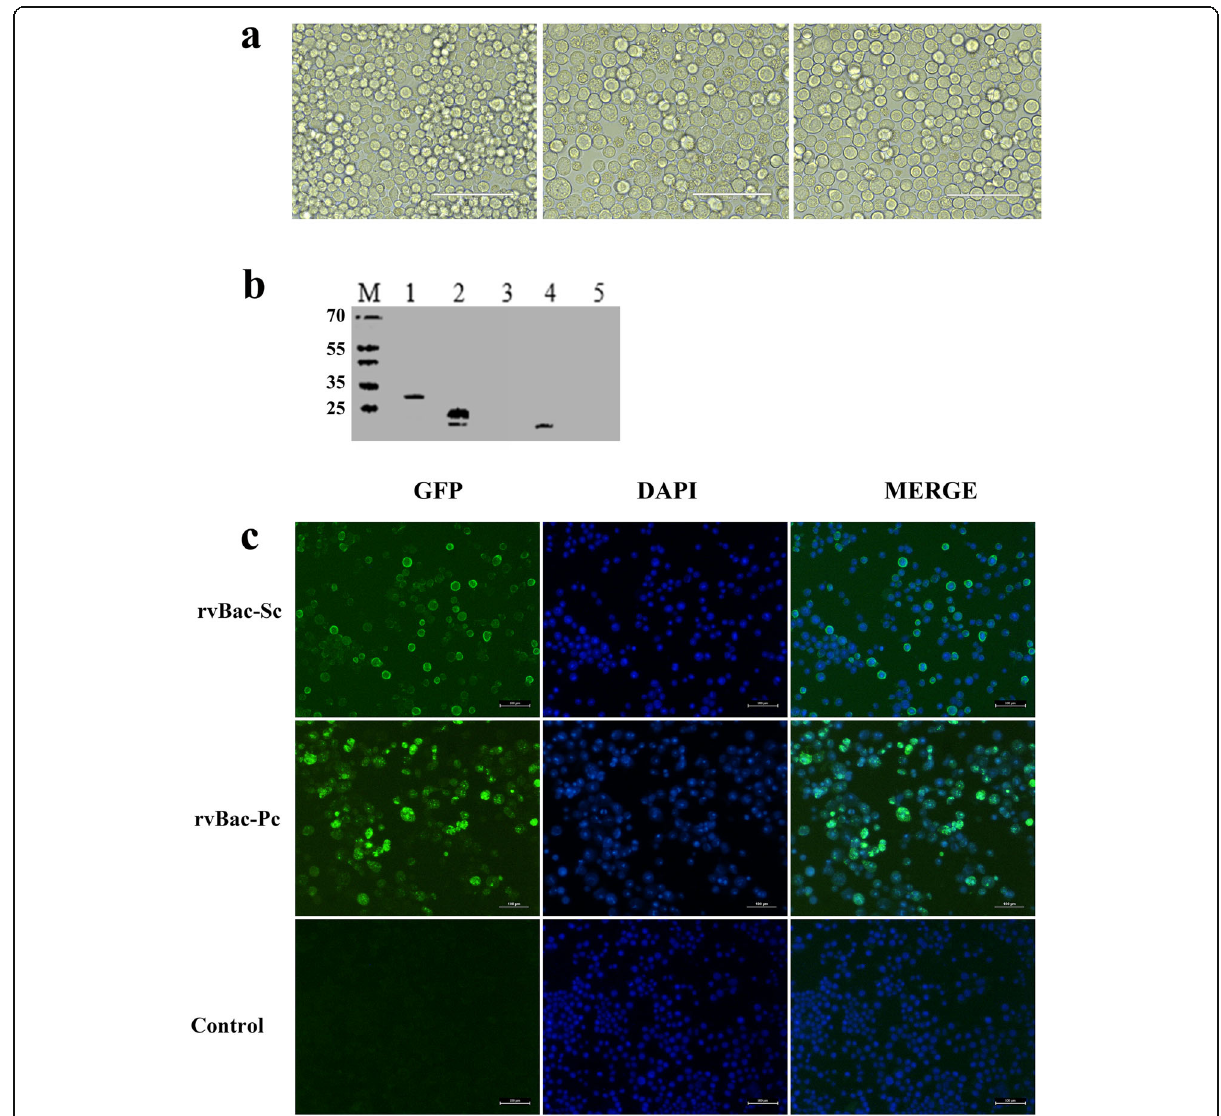
Fig. 1 Verification of PCV3 Cap protein expression in Sf9 cells. a Cytopathic effect in Sf9 insect cells transfected with recombinant bacmids. The left panel shows Sf9 cells, the middle panel shows Sf9 cells transfected with rvBac-Sc, and the right panel shows rvBac-Pc-transfected Sf9 cells. b Identification of recombinant Cap protein expression by western blot. Lane 1, cell lysate of Sf9 cells infected with rvBac-Pc. Lane 2, cell lysate of rvBac-Sc-infected Sf9 cells. Lane 3, supernatant of rvBac-Pc-infected Sf9 cells. Lane 4, supernatant of Sf9 cells infected with rvBac-Sc. Lane 5, cell lysate of mock-infected Sf9 cells. M, Marker. c Identification and localization of PCV3 Cap protein in infected Sf9 cells by IFA. rvBac-Sc, Sf9 cells infected with rvBac-Sc. rvBac-Pc, Sf9 cells infected with rvBac-Pc. Con, mock-infected Sf9